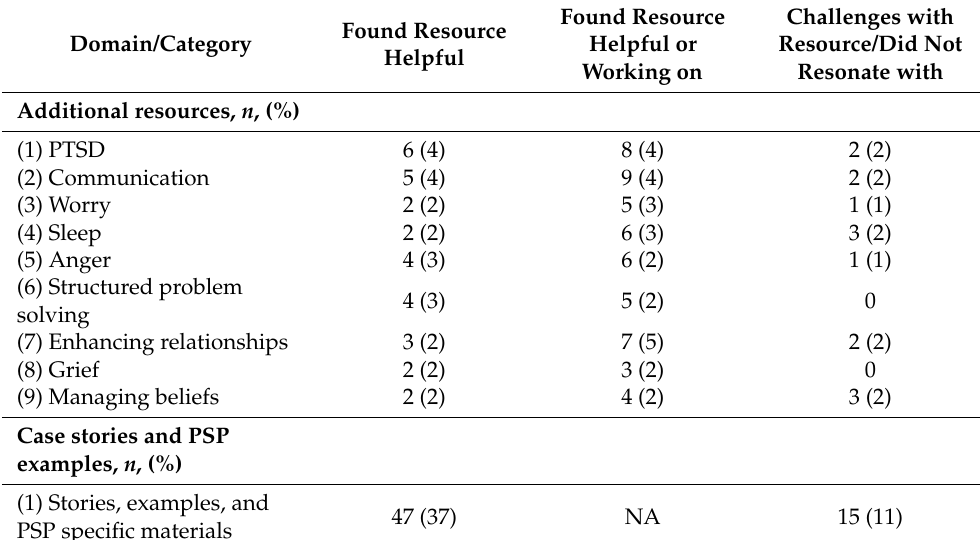
Table 6. Additional resources and PSP case stories that clients found helpful, found helpful or were working on without necessarily finding them helpful, or found challenging ( N =